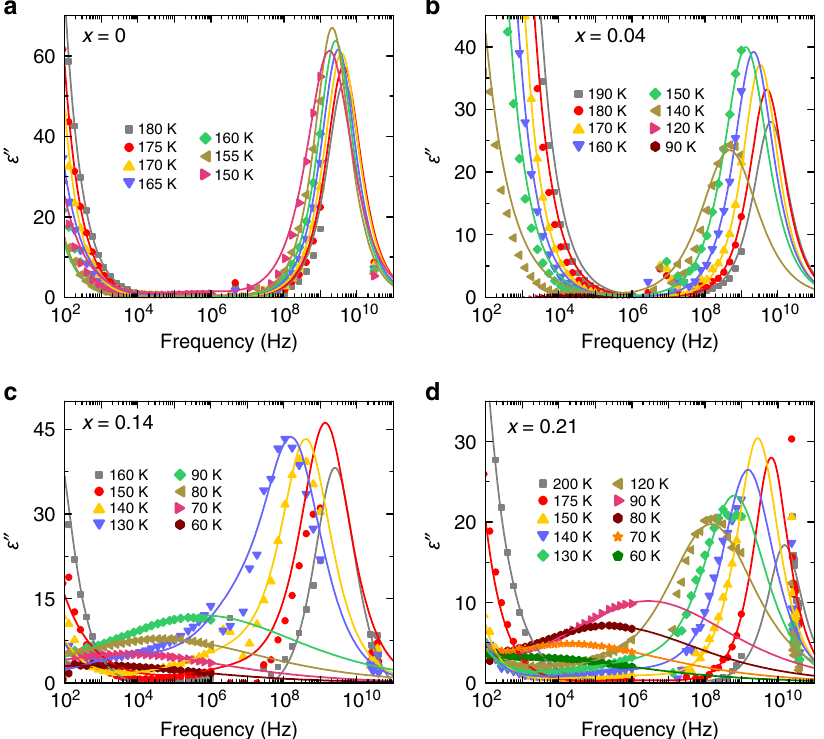
Fig. 4 Frequency dependent dielectric permittivity of mixed MA 1 − x DMA x PbBr 3 perovskites. Frequency dependence of the imaginary part of the complex dielectric permittivity at selected temperatures of a x = 0, b 0.04, c 0.14, and d 0.21 single crystal compounds. The curves are the best fi ts to Eq.